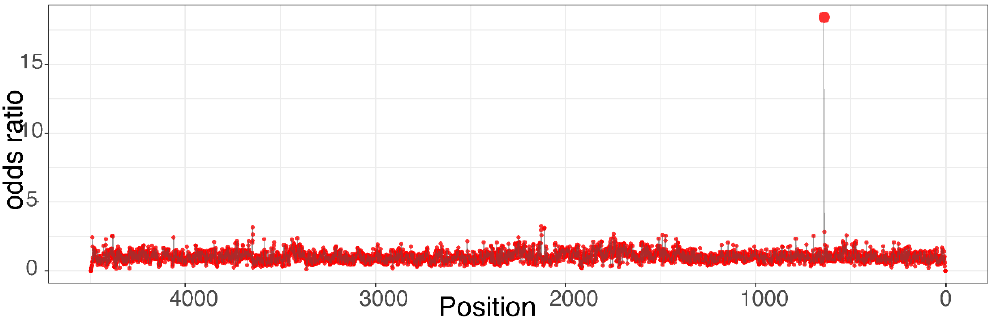
Figure 1. Representative odds ratios plot of a plasmid carrying a DNA adduct at position G640. The odds ratios of individual position were calculated using ELIGOS by comparing error at specific base on negative strand between plasmid carrying a DNA adduct at position G640 with the control plasmid, which has no adduct. Using the approach, the correct adduct location can be